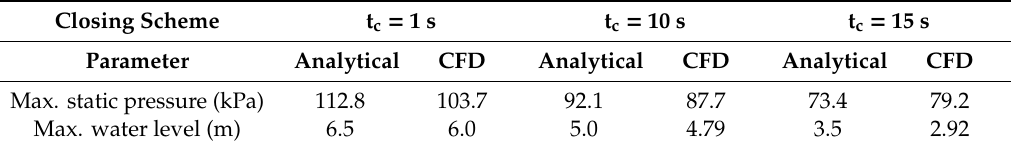
Table 4. Comparative analysis of analytical and numerical results.